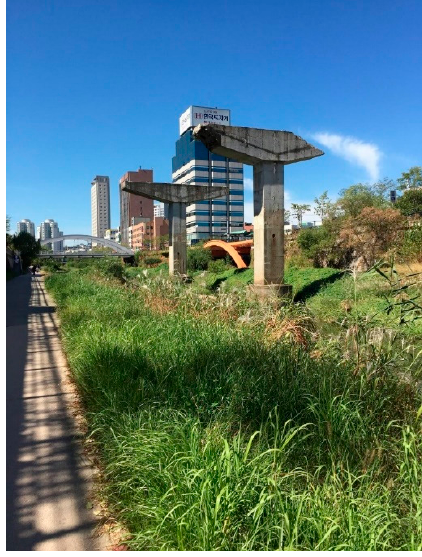
Figure 18. Remains of the columns of the highway ramp.